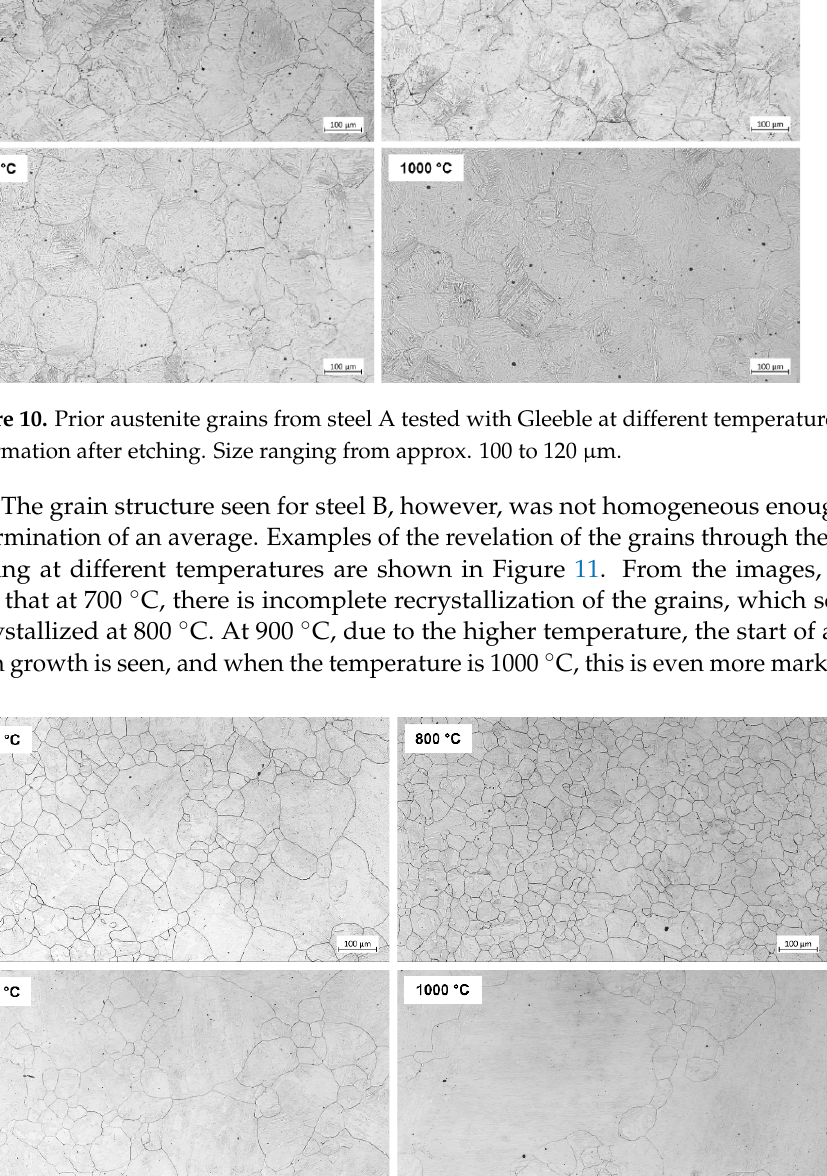
Figure 10 for different temperatures. From the linear intercept measurements carried out